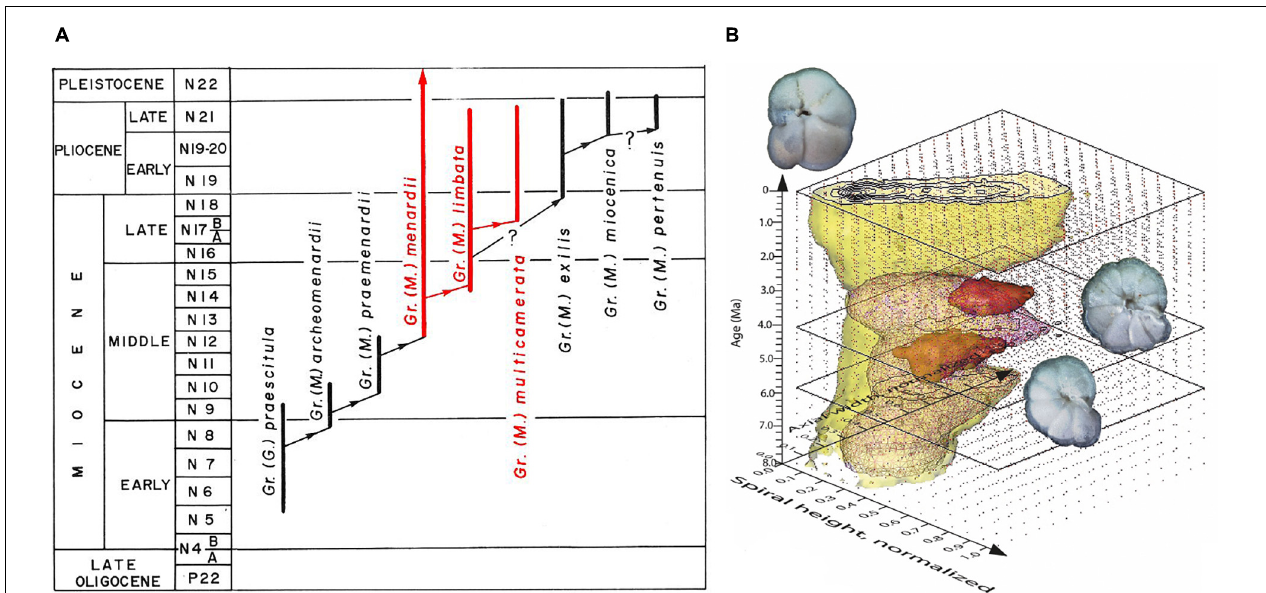
FIGURE 1 | The evolution of menardiform globorotalids (planktonic foraminifera) during the Miocene through Quaternary. (A) Phylogenetic scheme redrawn from Text Figure 14 on p. 121 in Kennett and Srinivasan (1983), with permission from the authors. (B) Volume-density diagram (VDD) for the Globorotalia menardii-limbata-multicamerata lineage during the past 8 million years at ODP Hole 925B based on length vs. width measurements of the shells in a keel view (from Knappertsbusch, 2016, 2022). One of the goals in that study was to find empirical evidence for the morphological splitting of G. limbata–G. multicamerata from ancestral G. menardii . For more information about the development of VDDs; see also Knappertsbusch and Mary